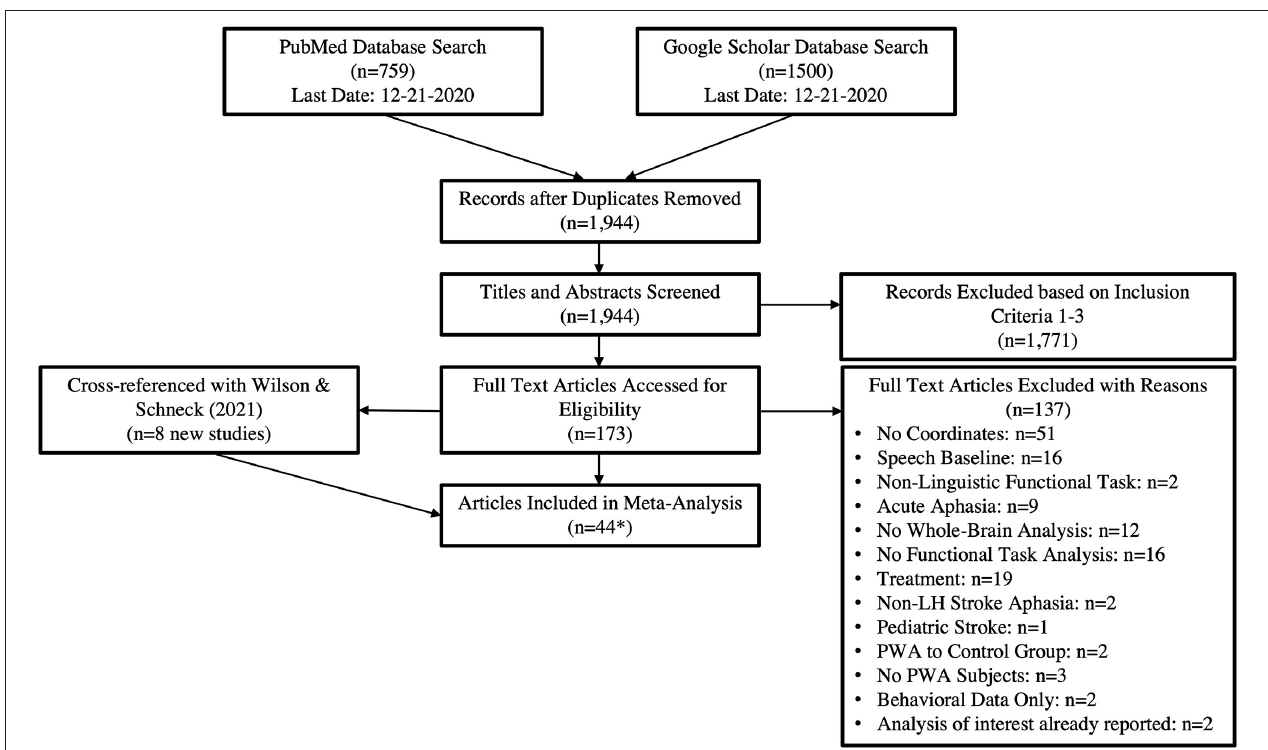
FIGURE 1 | The PRISMA flow diagram adapted for our literature search. *The 44 articles resulted in 49 tasks as five papers included both production and comprehension tasks. This resulted in 29 production and 21 comprehension tasks being included in the analyses.